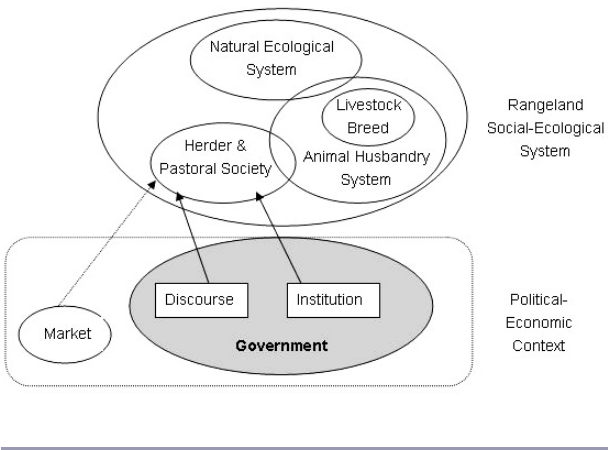
Fig. 2 . The analytical framework used in our